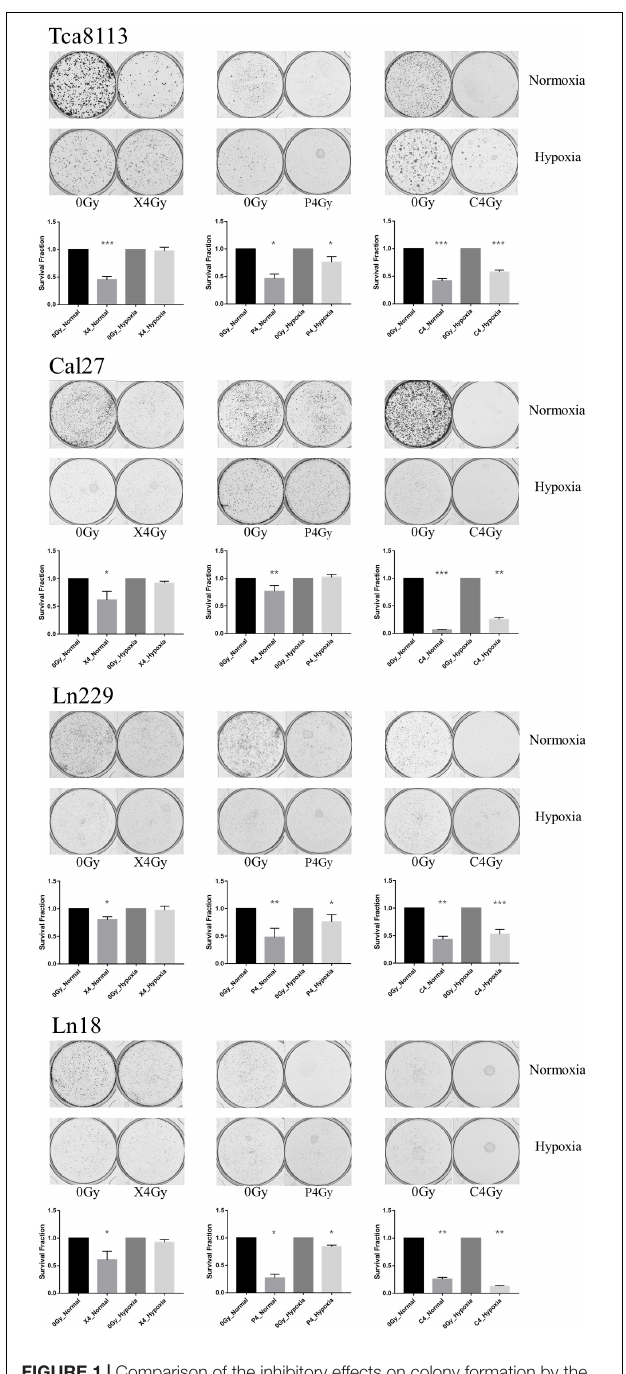
FIGURE 1 | Comparison of the inhibitory effects on colony formation by the three types of radiation under normoxia and hypoxia. Tumor cells were irradiated with 4Gy (physical dose) photon, proton, or carbon-ion radiation under normoxia or hypoxia conditions. Survival fraction (SF) was calculated as: colony formation rate in the irradiated group/colony formation rate in the control group. The representative images of colony formation for each tumor cell group are shown in the upper panels. The histograms indicate the SF of tumor cells exposed to different types of radiation under normoxic and hypoxic conditions. Results are presented as mean ± s.d. Statistical significance of each irradiated group relative to the corresponding control group (0Gy) was indicated by asterisks. * p < 0.05, ** p < 0.01, and *** p <